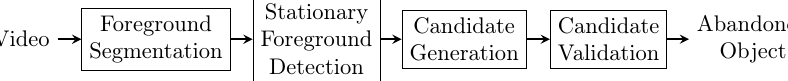
Figure 2. Canonical framework for abandoned object